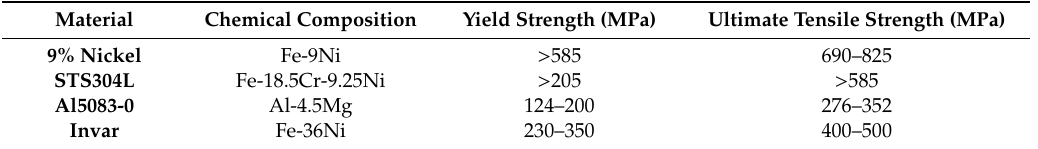
Table 1. IGC Code list of cryogenic fuel tank material.